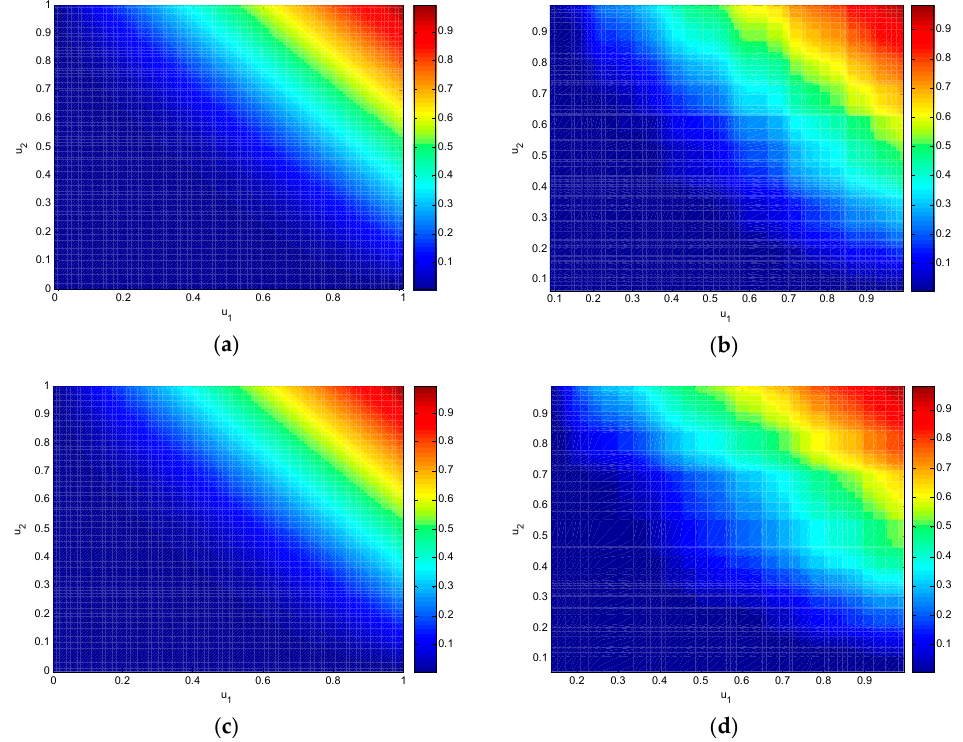
Figure 4. Shaded surfaces of empirical (( b ) and ( d )) vs . theoretical copula (( a ) and ( c )) at: Monreale (( a ) and ( b )); Palazzolo Acreide (( c ) and ( d )).